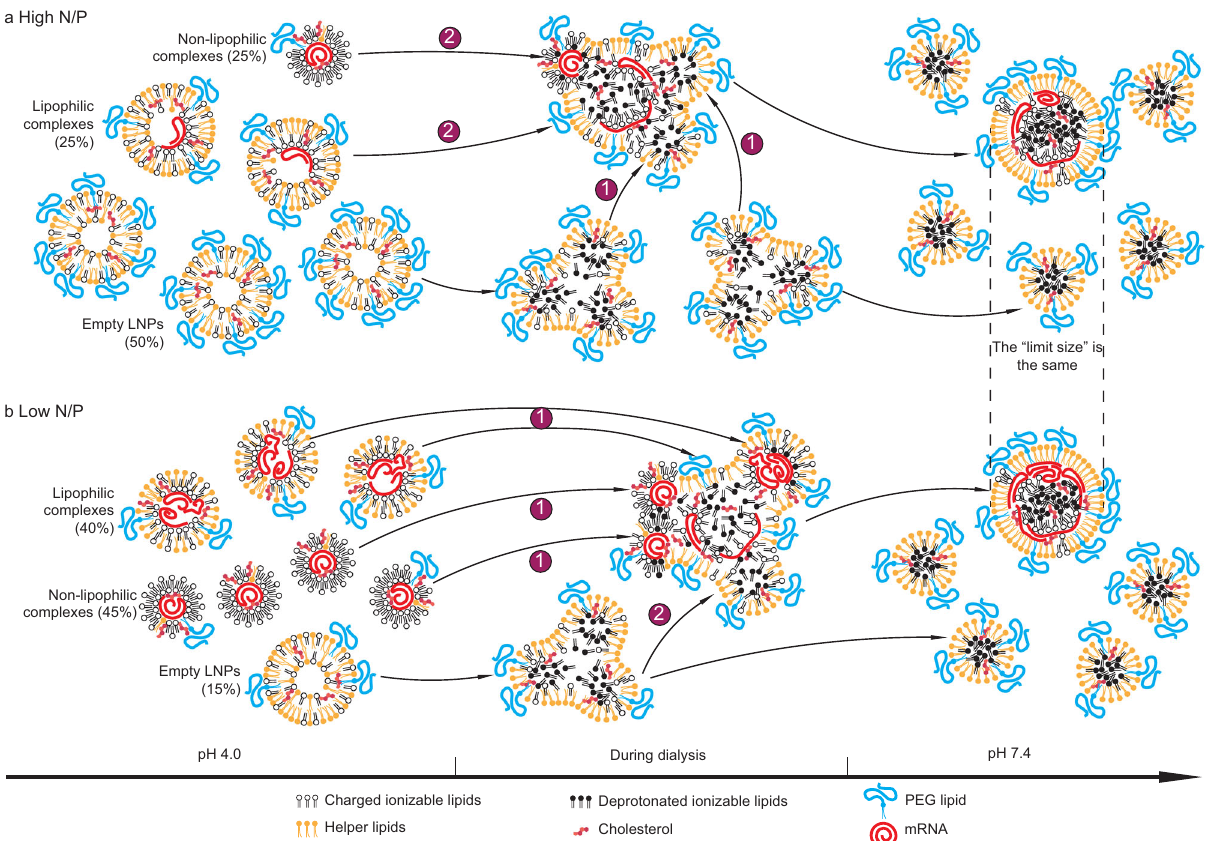
Fig. 6 | Mechanisms of determination of payload capacity and distribution of mRNA LNPs by N/P ratio. a , b The hypothesized assembly processes and char- acteristics of LNP formulation with a high N/P ratio a ; or a low N/P ratio b and compositiondrift during dialysisfrom pH4.0(left)topH7.4(right).AtpH4.0,the